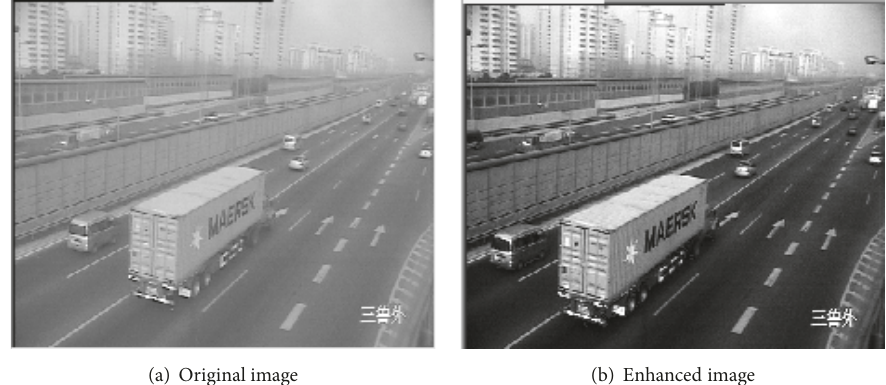
Figure 2: Original image and enhanced image.